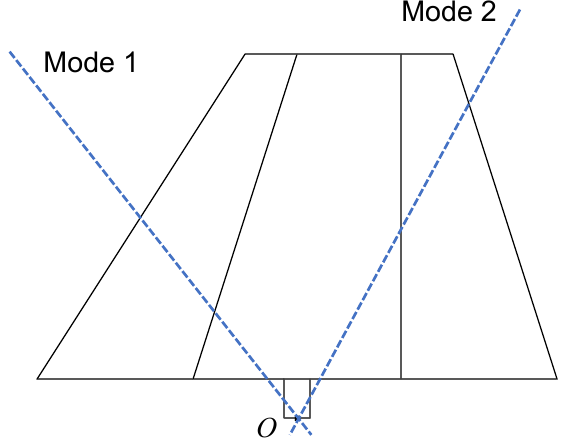
Figure 2. Geometrical schematic of the all-movable fin. All dimensions are in millimeters.